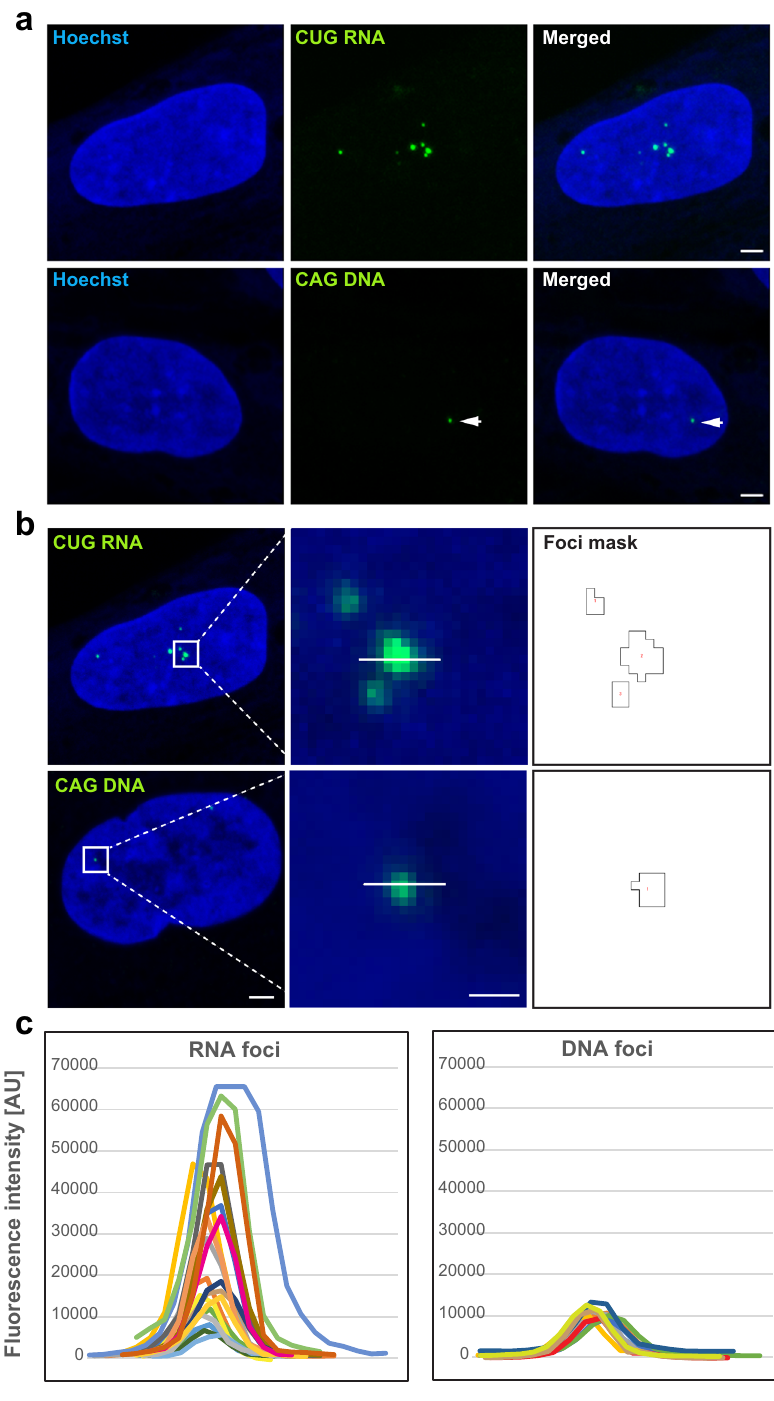
Figure 6. Detection of Mutant CUG Repeat RNA and Mutant CAG Repeat DNA in Nuclear Foci via FISH. ( a ) Representative FISH images of mutant DMPK RNA and DNA foci in DM1 human fibroblasts. CUG repeat RNA foci were detected with (CAG) 10 probe, whereas CAG repeat DNA foci with (CTG) 10 probe, both labeled with Alexa 488. The nuclear area was identified by Hoechst stain. The arrowheads indicate dim DNA foci. Scale bar, 2 µ m. ( b ) 16-bit FISH images (raw data) of RNA and DNA foci and their fluorescence intensity in green channel determined by masks with the outline of recognized foci. Scale bars, 2 µ m (left panels) and 0.5 µ m (middle panels). ( c ) Maximum values of FISH intensity for RNA and DNA foci from line profiles (as shown in panel b) for randomly selected nuclei of VRS fibroblast cell line. Each plotted color line represents one